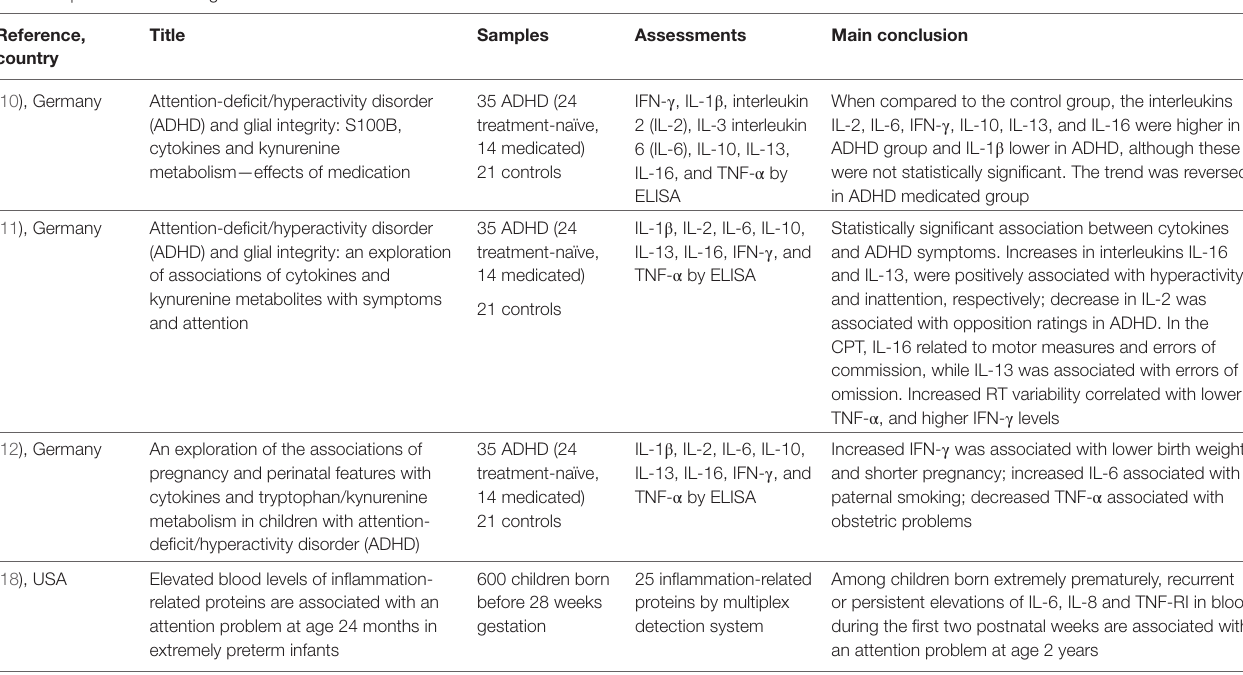
taBLe 1 | Studies measuring inflammation in